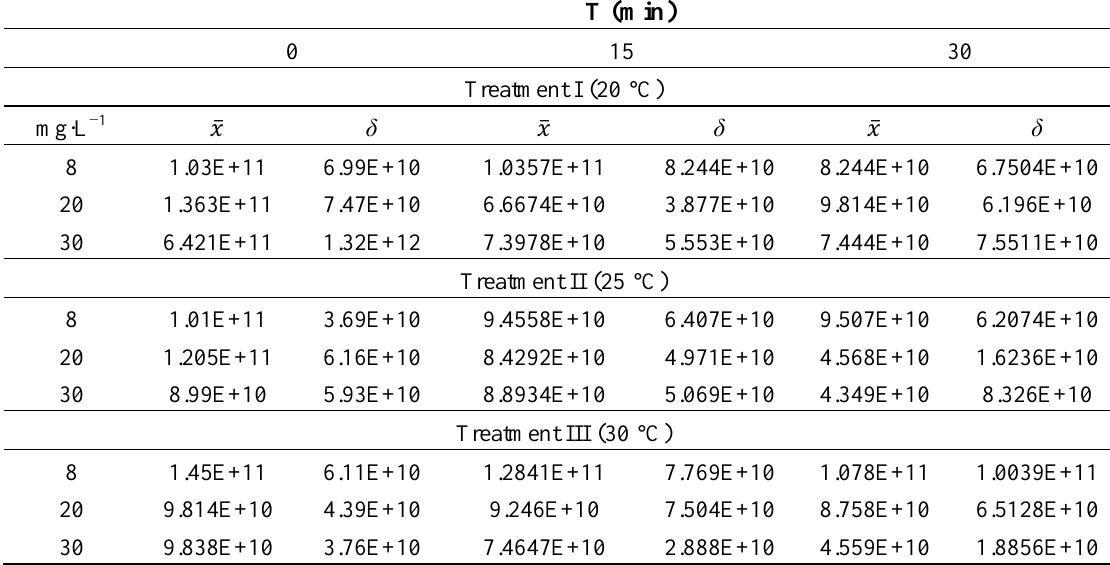
Table 4. Means and standard deviations (CFU·100 mL −1 ) obtained for the bacterial strains during the disinfection